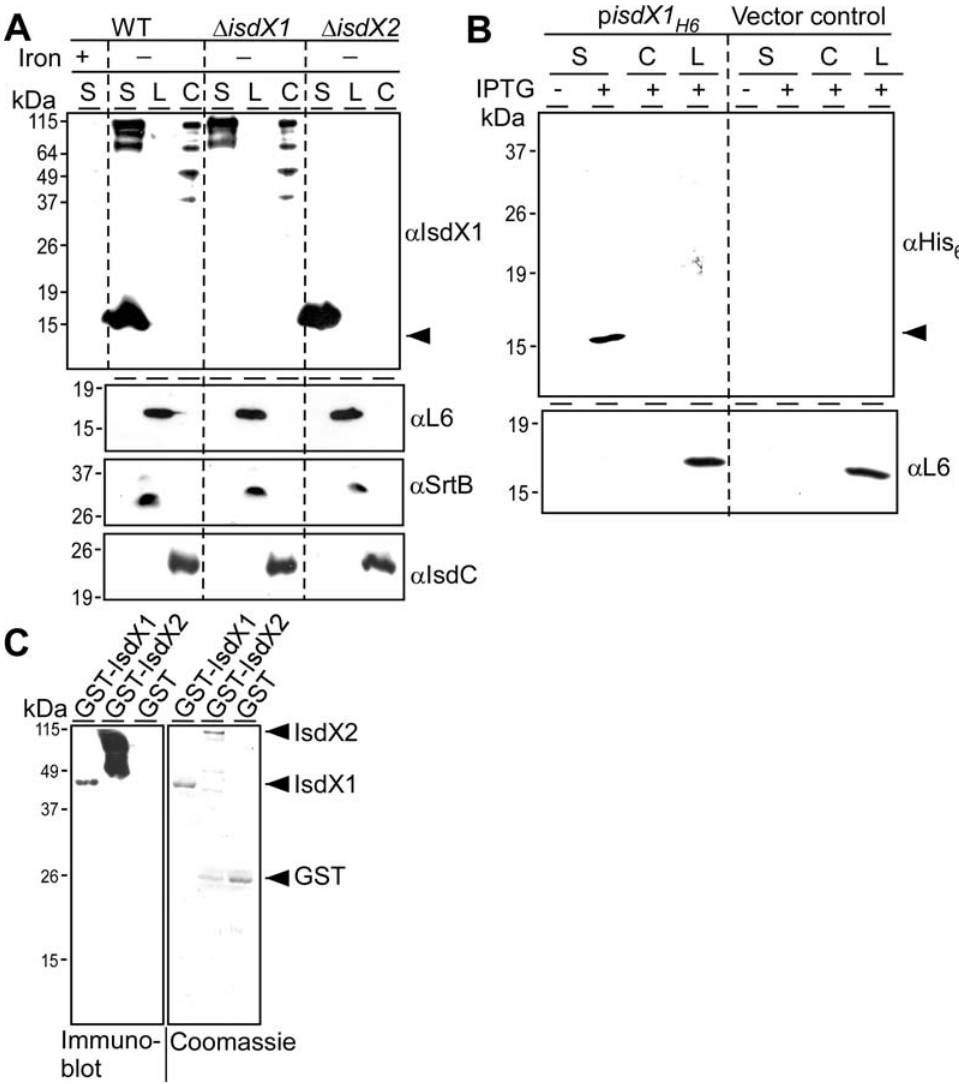
Figure 2. B.anthracis secretes IsdX1. ( A and B ) B. anthracis strains were grown in iron-replete or iron-depleted medium for 12 hours, followed by fractionation of cultures into secreted (S), cell wall (C), and lysate (L) fractions. Samples were analyzed by immunoblot with antibodies specific for IsdX1, L6 (ribosomal protein), SrtB (sortase B membrane protein), and IsdC (cell wall anchored protein). ( C ) Serum of guinea pigs that recovered from anthrax infections was used for immunoblot with purified GST-IsdX1, GST-IsdX2 or GST ( left panel ). The arrows denote SDS-PAGE mobilities of proteins (Coomassie, right panel ) used for the immunoblot analysis. The migratory positions of molecular weight markers are indicated (kDa).